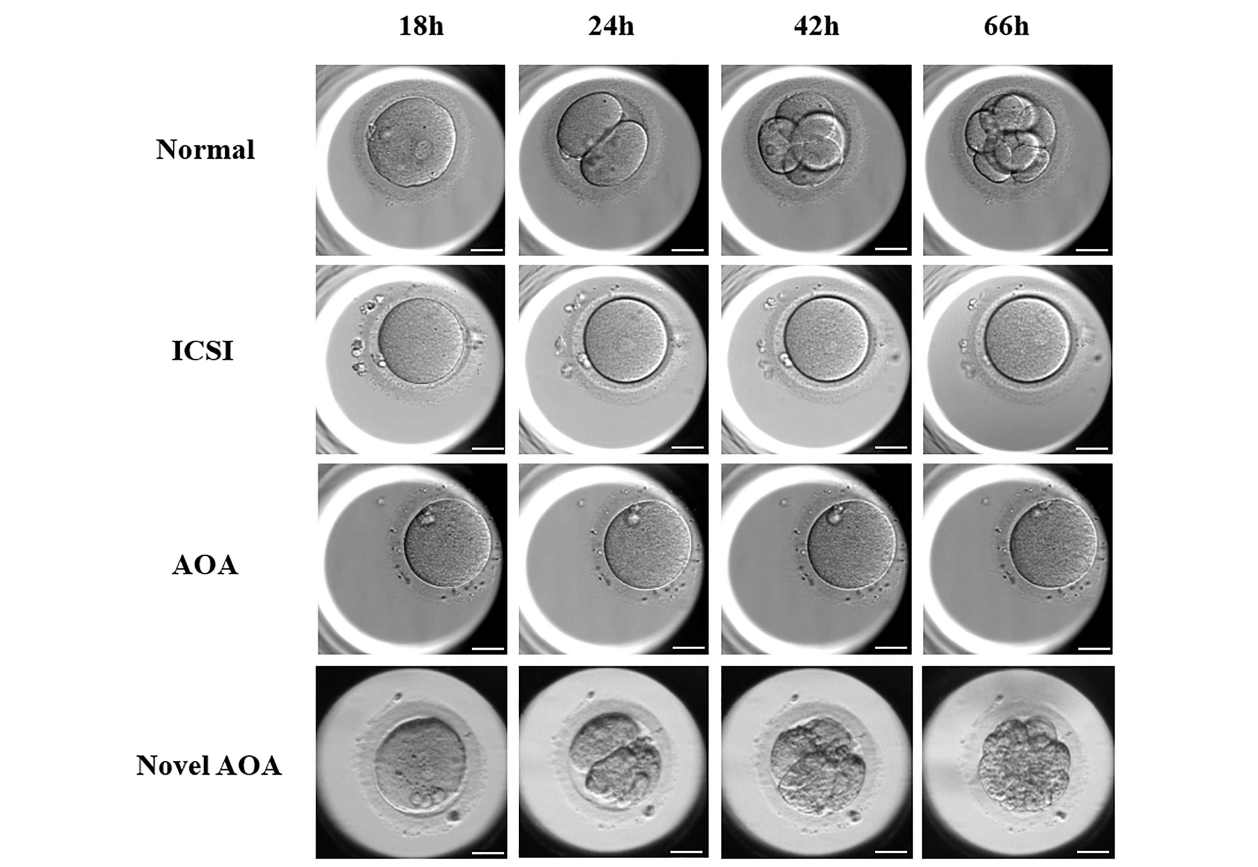
FIGURE 2 | The exhibition of embryos at the different stages using various techniques. Images of embryos at 18, 24, 42, and 66 h after insemination were presented. In the ICSI group and the conventional ICSI-AOA group, PN and cleavage cannot be observed in those oocytes, whereas, the oocytes treated by novel AOA can form pronuclei and develop to cleavage stage embryos normally. Scale bar = 50 µ